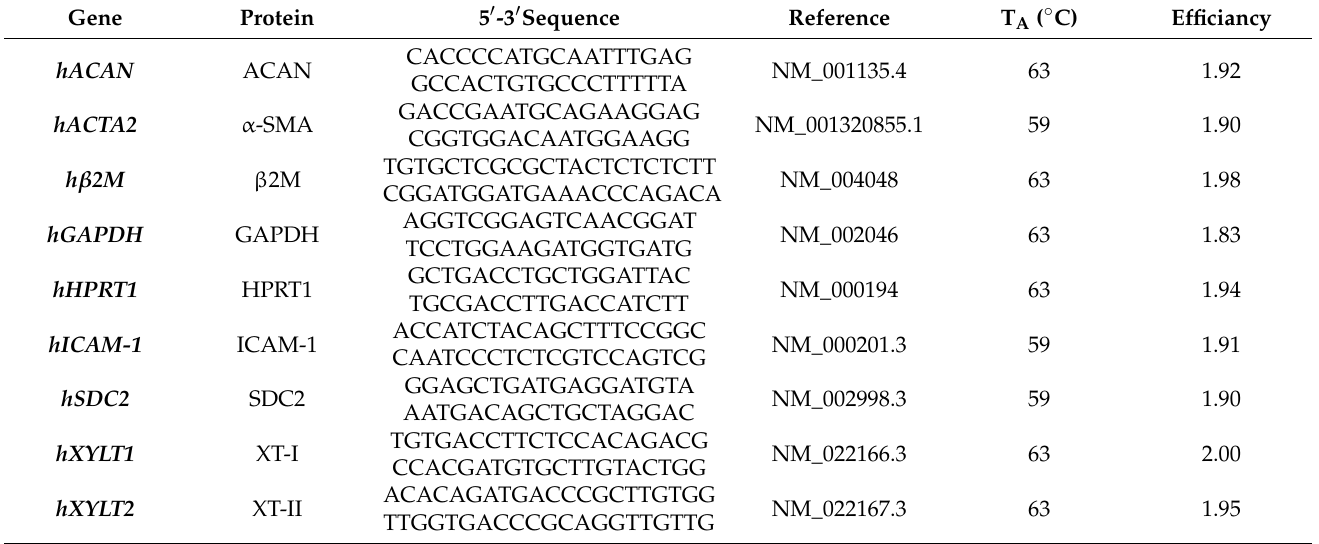
Table 1. Sequences and annealing-temperatures of the used quantitative real-time PCR